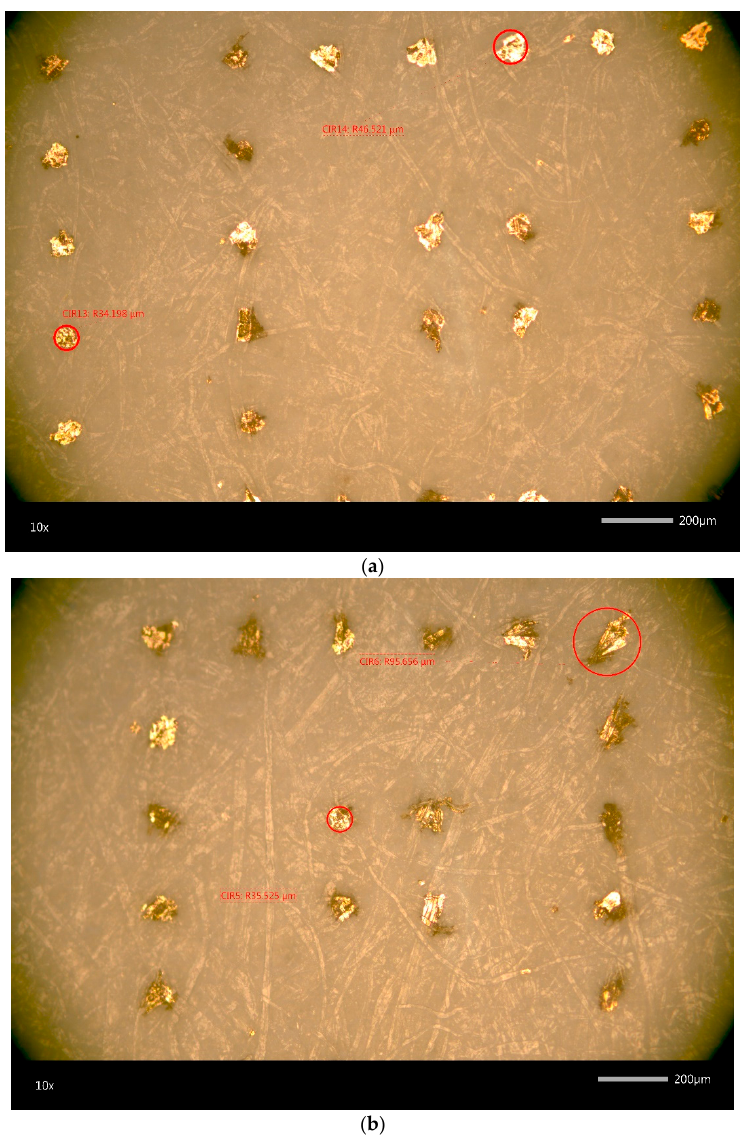
Figure 5. Microscopic images (10×) of printed single drops before sintering on type 4 ( a ) and type 7 ( b ) substrate, the size bar is 200µm in length.